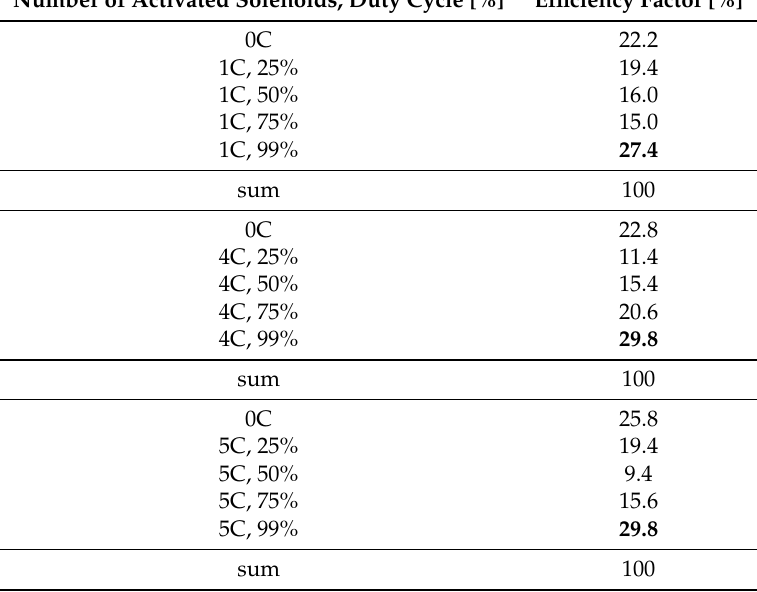
Table 3. Efficiency factors calculated for MFC1, depending on the number of solenoids and the value of duty cycle of a PWM signal.